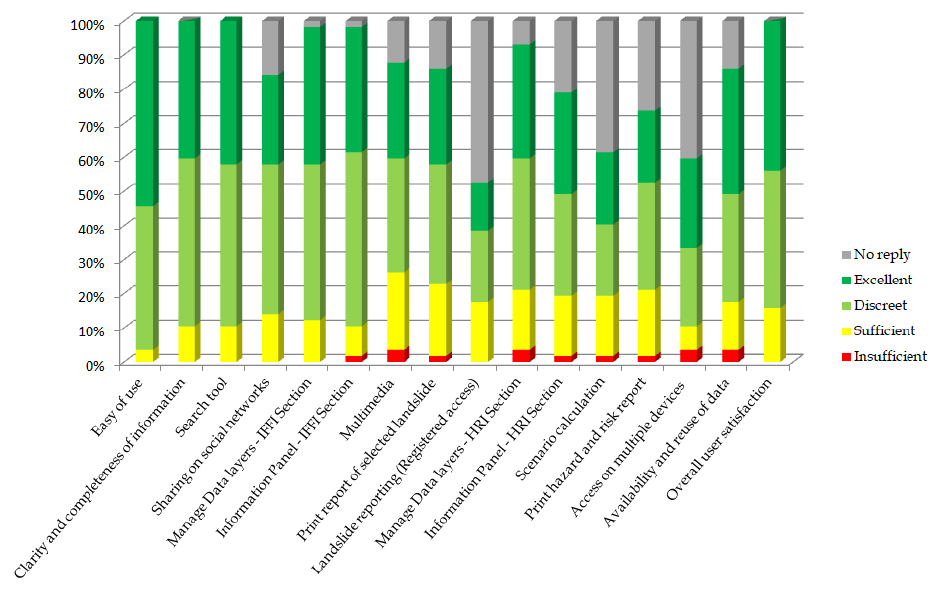
Figure 11. IdroGEO platform user satisfaction statistics (sample: 57 survey answers).